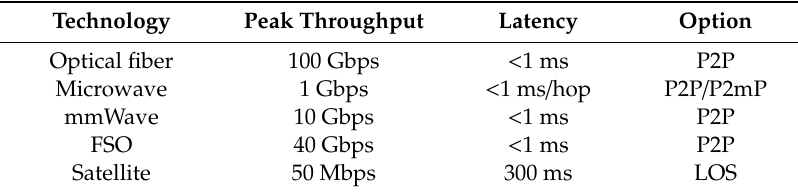
Table 4. Comparison of the achieved data rates and latencies in the existing important backhaul technologies